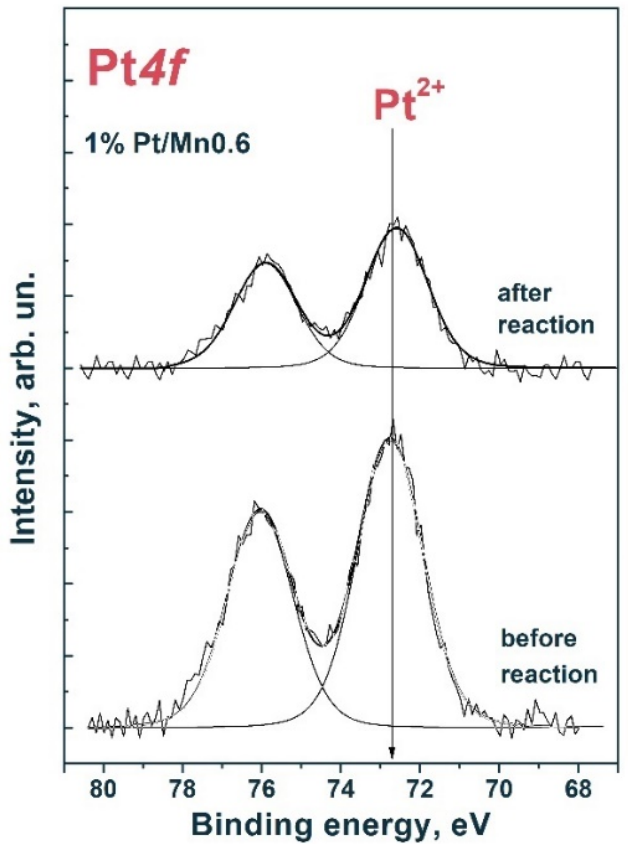
Figure 10. Pt 4f spectrum of fresh samples and those using 1% Pt/Mn0.6 HT120. The spectrum is normalized to the integral total intensity of the corresponding Cd 3d and Mn 2p spectra.